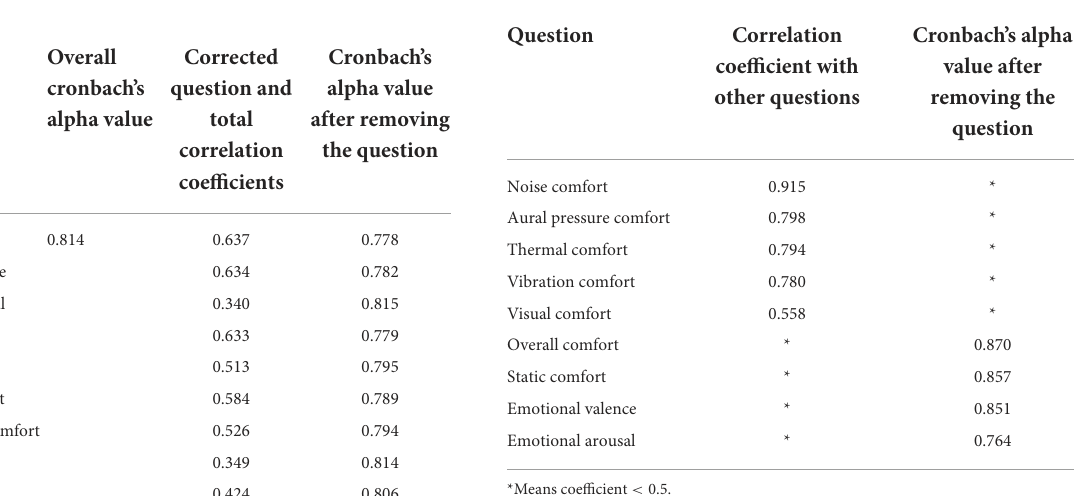
TABLE 3 Component matrix after